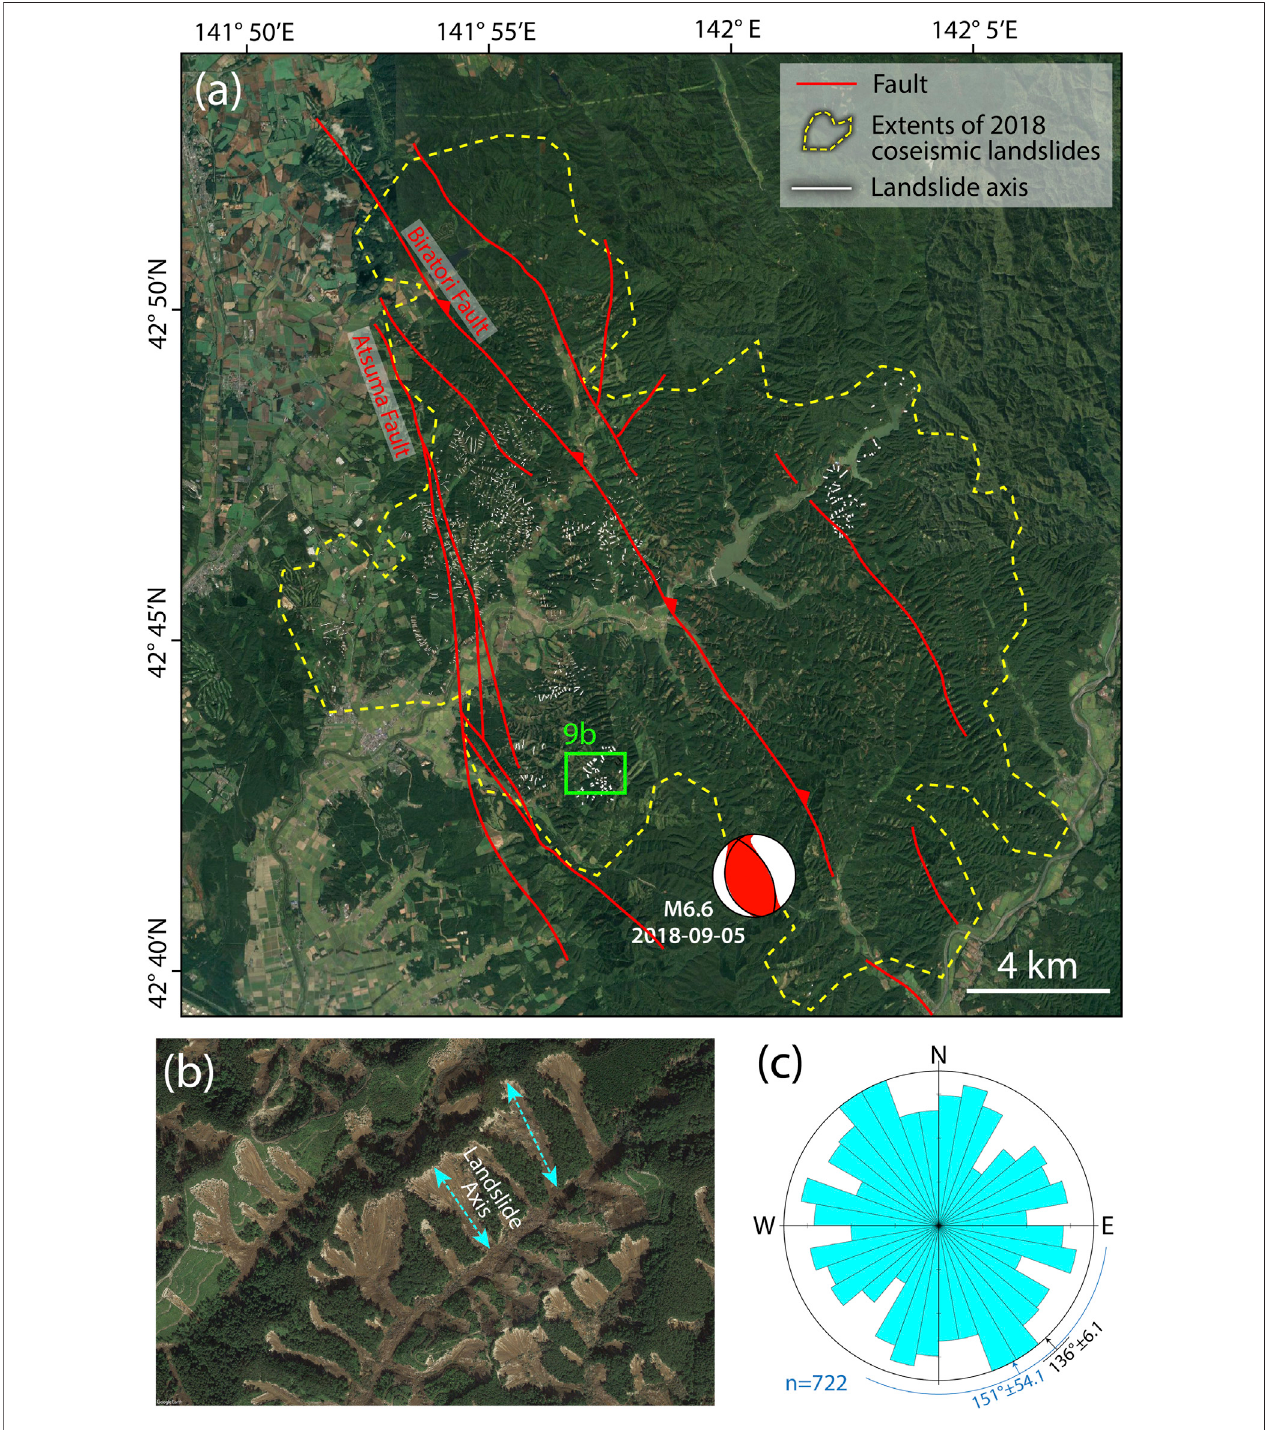
FIGURE 8 | (A) Google Earth © satellite image of the Hokkaido landslide region showing the 270 km 2 extent of coverage of the affected area. (B) A representative satellite image showing the distribution of the individual landslides and the manually digitized axial trends (long axes) of the landslides (see Dataset S1 for digitized data). (C) Azimuth-frequency distribution of the mapped axial trends of the coseismic landslides.